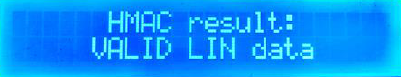
Figure 17. Master node’s second HMAC display.